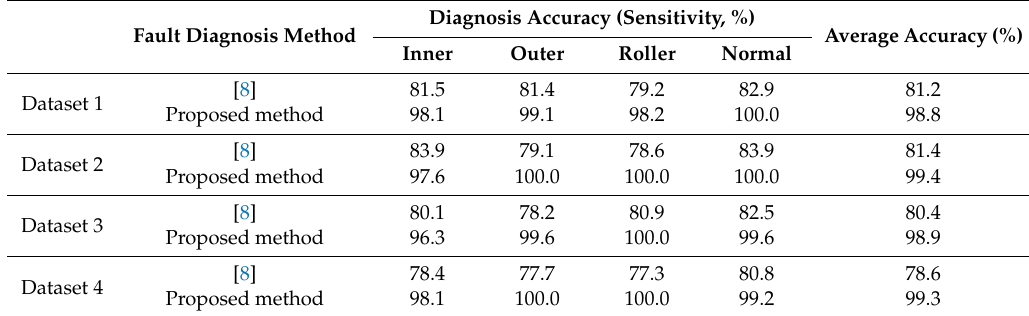
Table 4. Diagnosis accuracy of the proposed method for single faults compared to the method in the paper